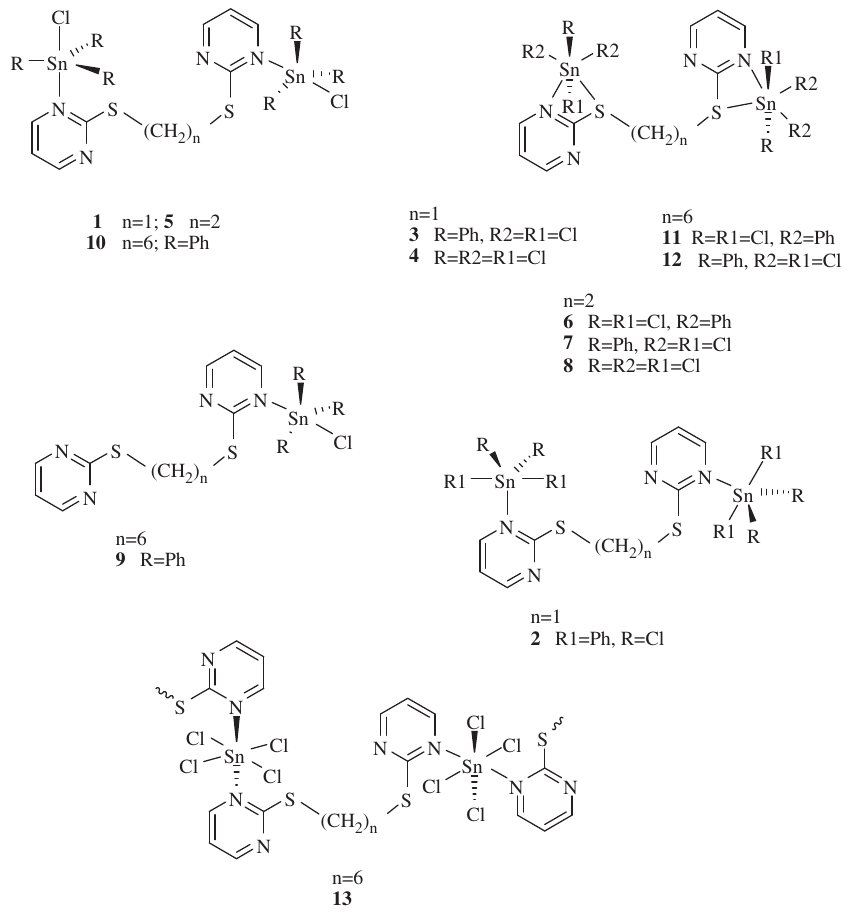
Figure 2 Possible structural arrangements of